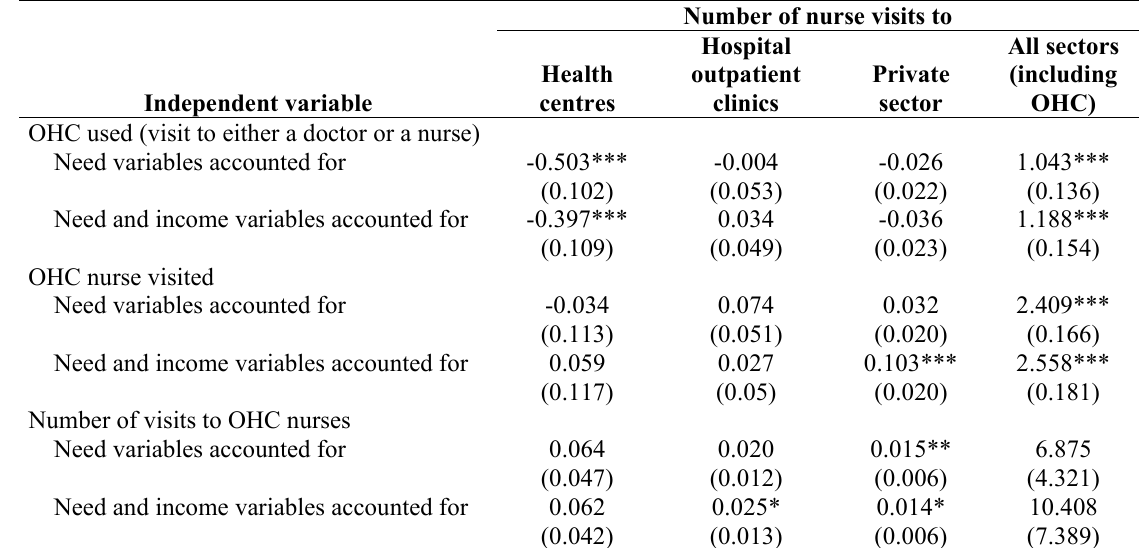
Table 4. Marginal effects of the associations between use of OHC and use of nurse services at other sectors.